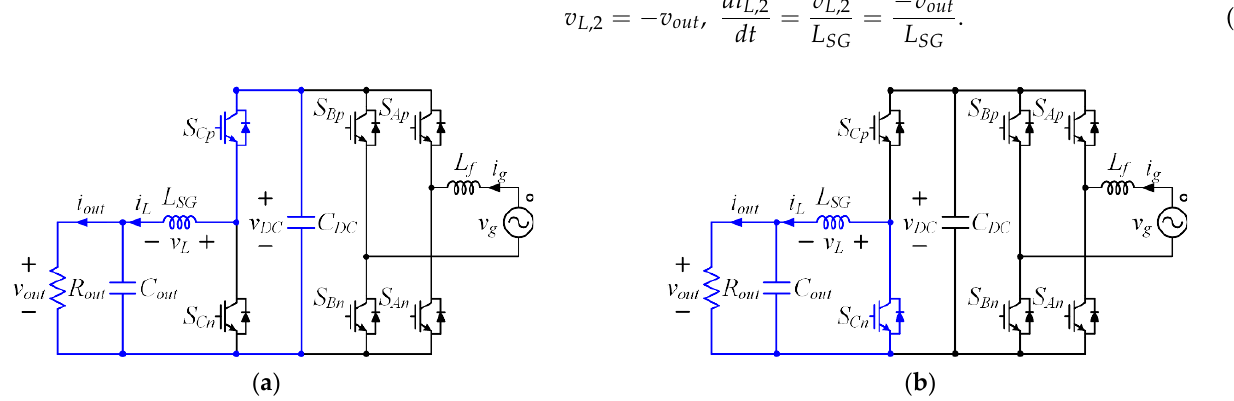
Figure 2. Simplified circuit configuration of integrated OBC which performs battery charging.